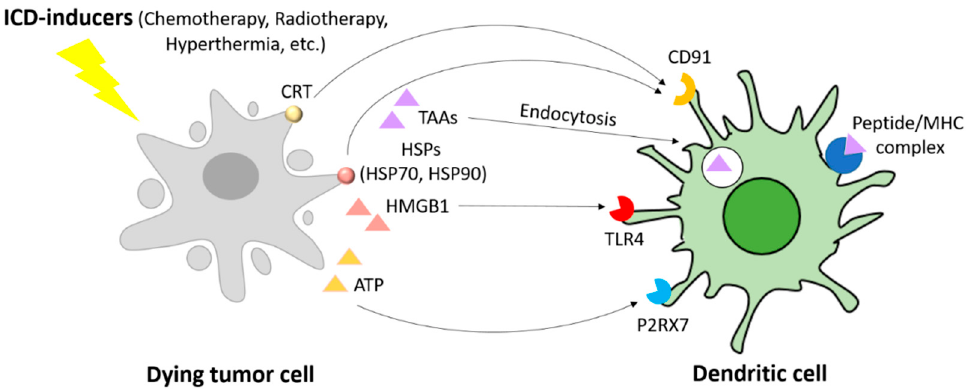
Figure 6. Schematic representation of the molecular mechanism occurring during immunogenic cell death process. Overall, the binding of these DAMPs to cognate receptors on the surface of myeloid or lymphoid cells will favour the uptake of tumour cell debris by DCs and macrophages,